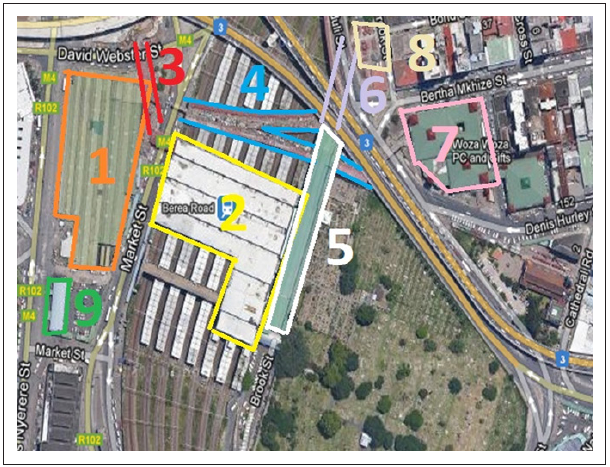
FIGURE 1: Aerial view of the nine markets of Warwick (1) Early Morning market; (2) Berea Station mart; (3) Music Bridge; (4) Herb market; (5) Brook Street market; (6) Lime and Impheph market; (7) Victoria Street market; (8) Bead market; (9) Bovine Head